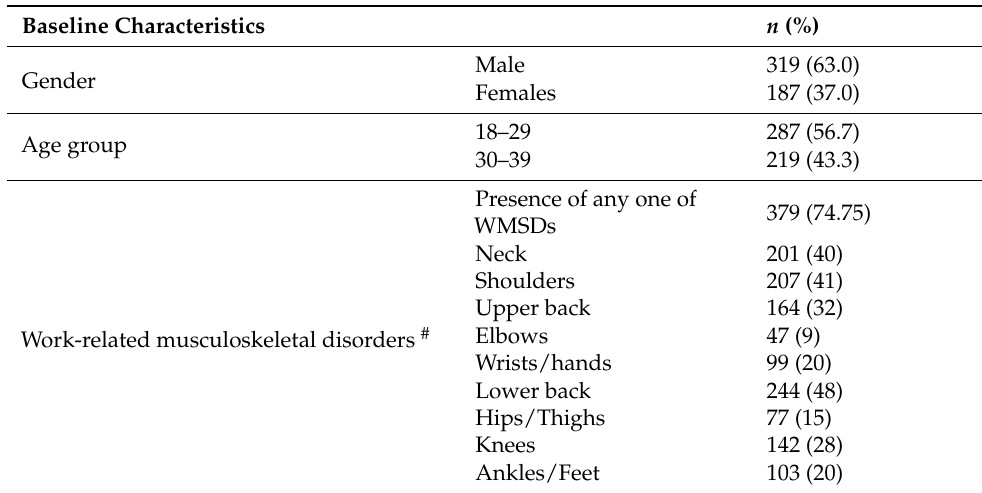
Table 1. Descriptive characteristics of the